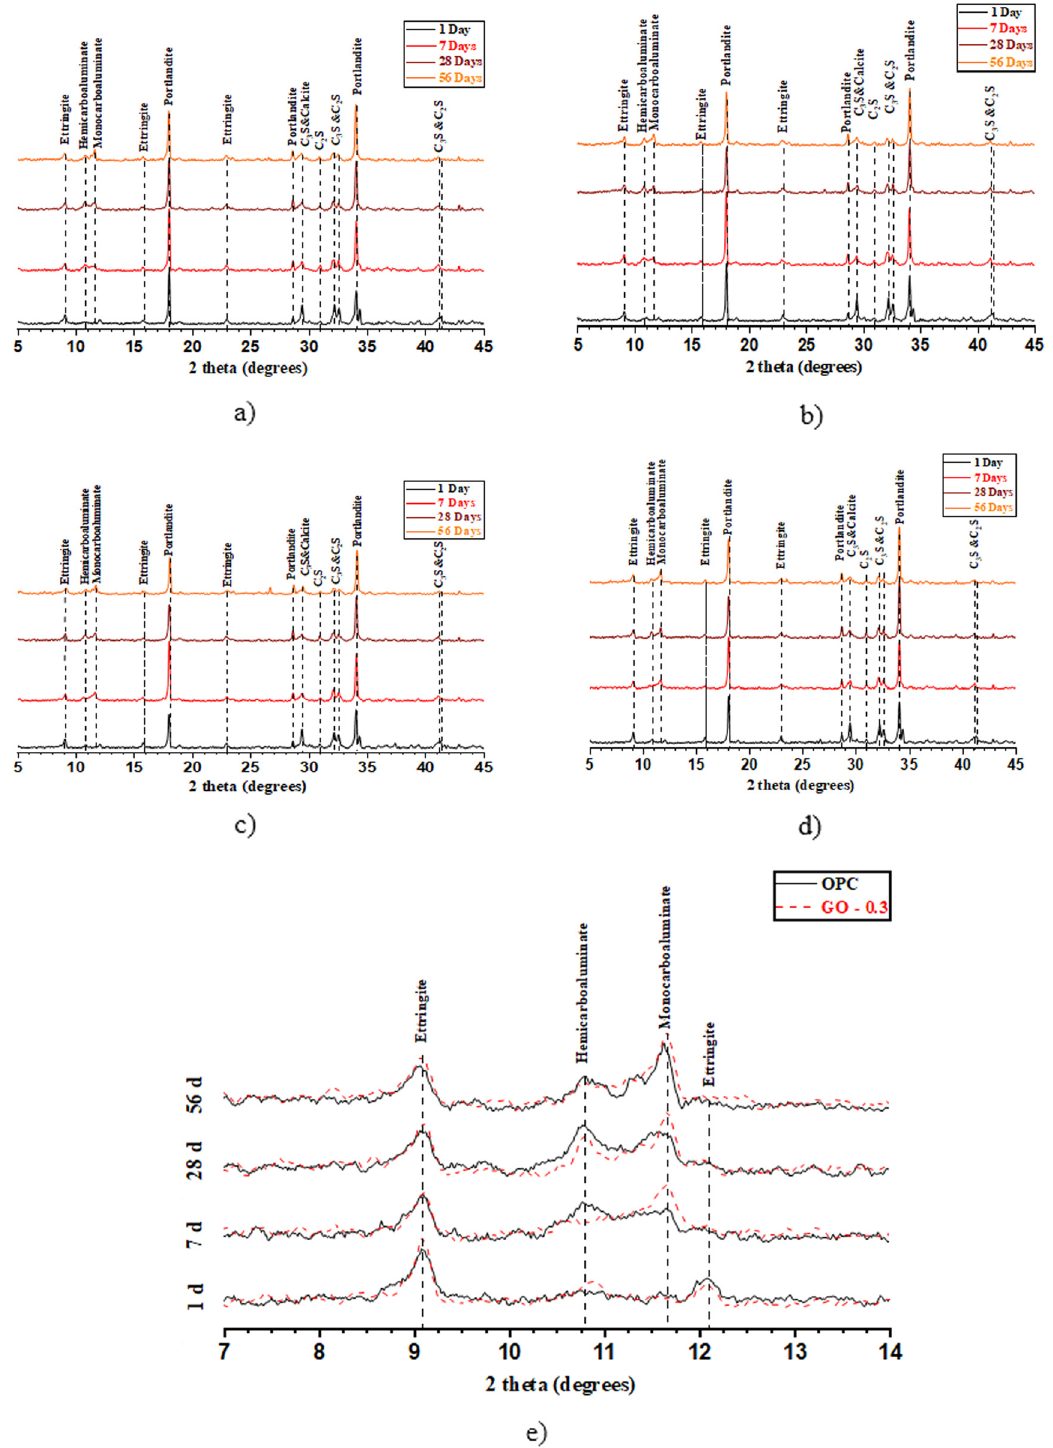
Figure 5: XRD patterns of OPC and GO - incorporated cement paste: ( a ) OPC, ( b ) GO - 0.1, ( c ) GO - 0.2, ( d ) GO - 0.3, and ( e ) OPC and GO - 0.3 specimens 2 theta ( 7 – 14° )